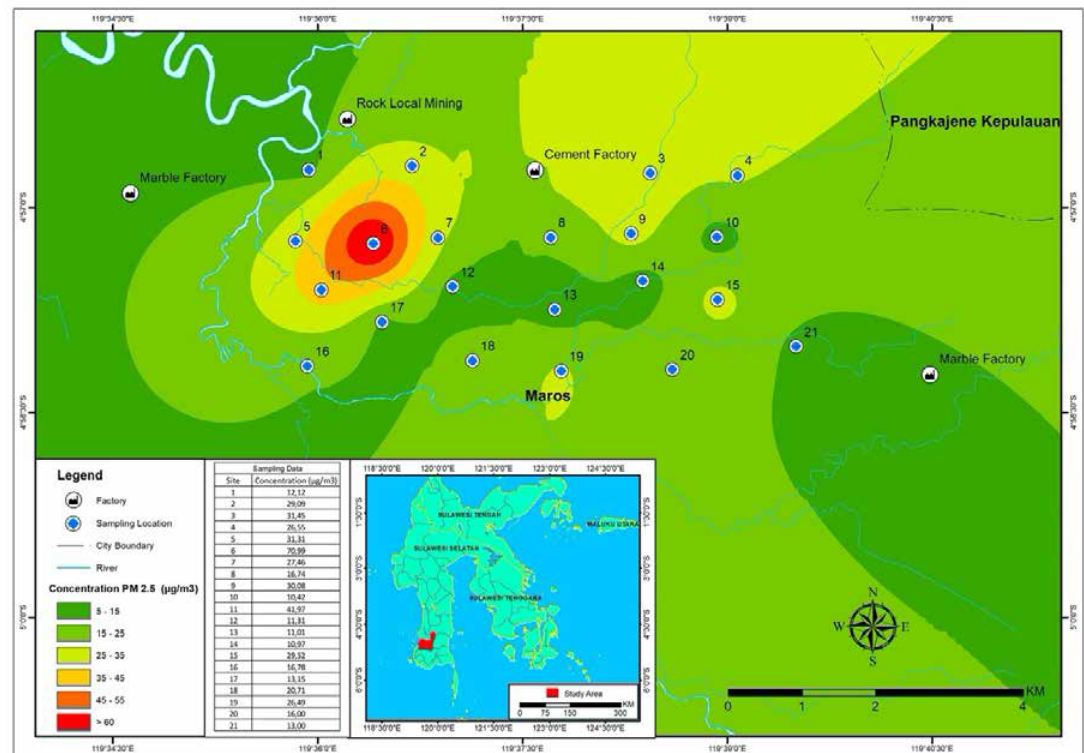
Fig. 3: The spatial distribution of PM 2.5 levels around the residential areas